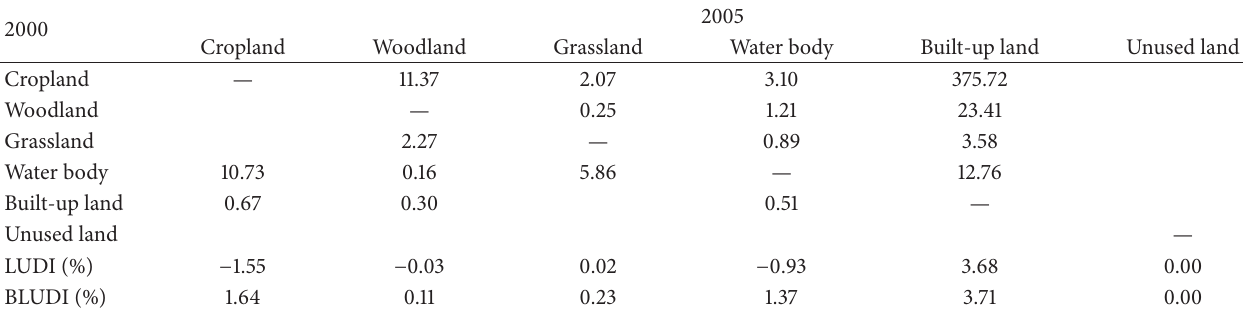
Table 3: Land use change detection matrix in the period of 2000–2005 (km 2 ).